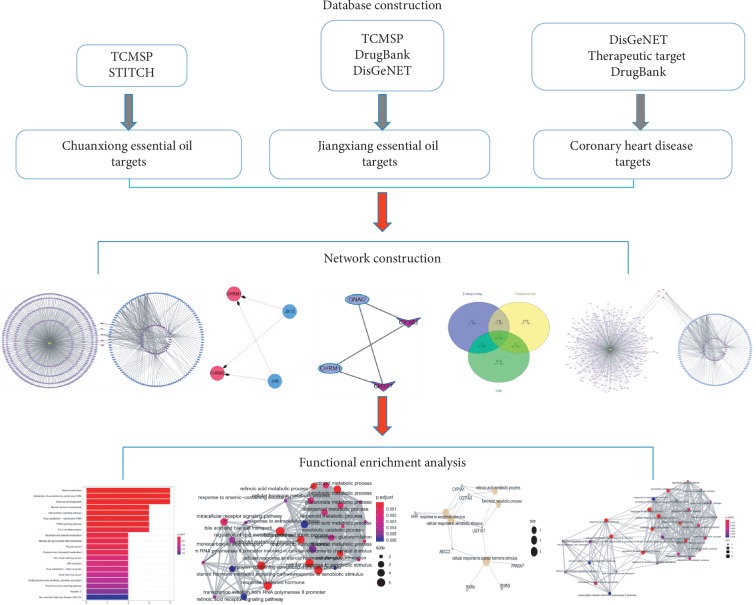
Process overview.